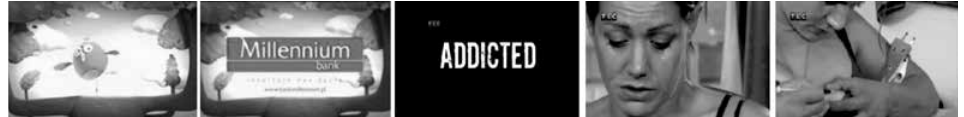
Figure 2(a). Incongruent and controversial 1: vignette (bank) attached to heroin addiction